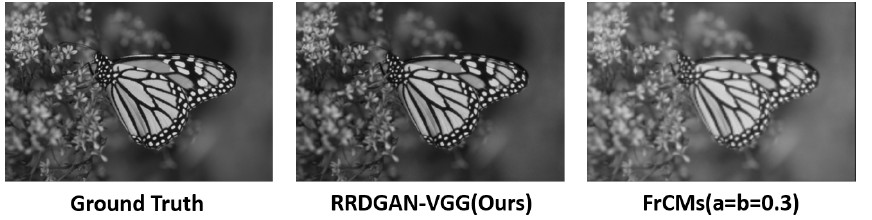
Figure 20. Comparing the super-resolution part of our method with Fractional Charlier moments using Set14.